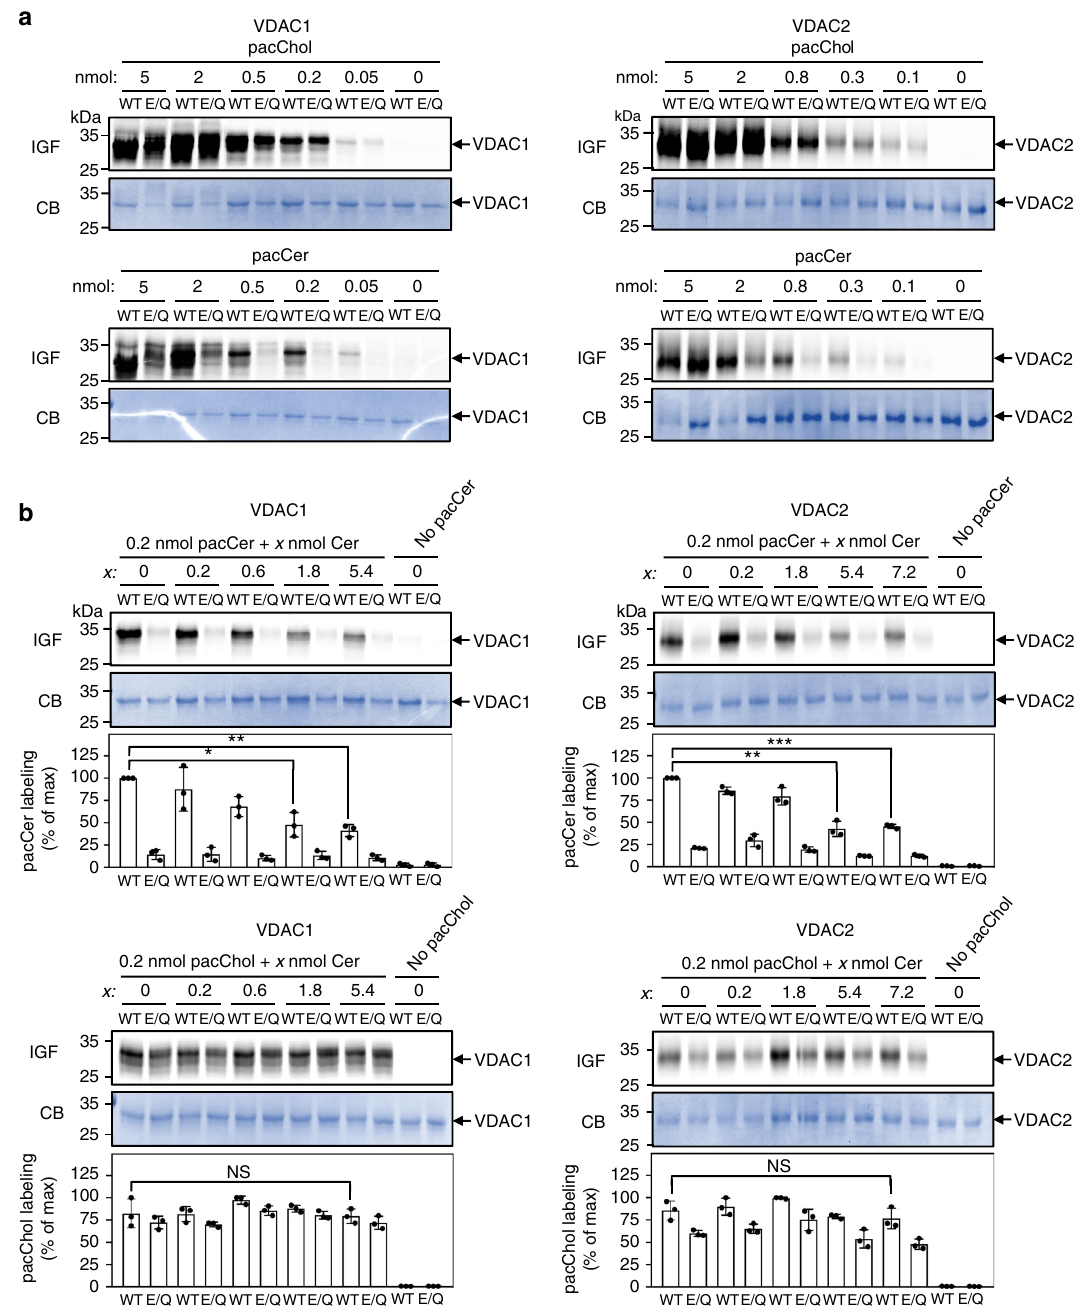
Fig. 5 Competitive inhibition of pacCer photolabeling of VDACs by C 16 -ceramide. a VDAC1, VDAC1 E73Q , VDAC2, and VDAC1 E84Q proteoliposomes were photolabeled with the indicated amount of pacCer or pacChol added from ethanolic stocks. Next, samples were click-reacted with AF647-N 3 , subjected to SDS-PAGE, and analyzed by IGF and CB staining. b VDAC1, VDAC1 E73Q , VDAC2, and VDAC1 E84Q proteoliposomes were photolabeled with 0.2 nmol pacCer or pacChol in the presence of the indicated amounts of natural C 16 -ceramide (Cer) added from ethanolic stocks and then processed as in a . Relative labeling ef fi ciencies were quanti fi ed and expressed as % of control (0.2 nmol pacCer or pacChol in the absence of Cer). Data are means ± s.d.; n = 3; * p < 0.05, ** p < 0.01, and *** p < 0.001 by two-tailed paired t -test. Source